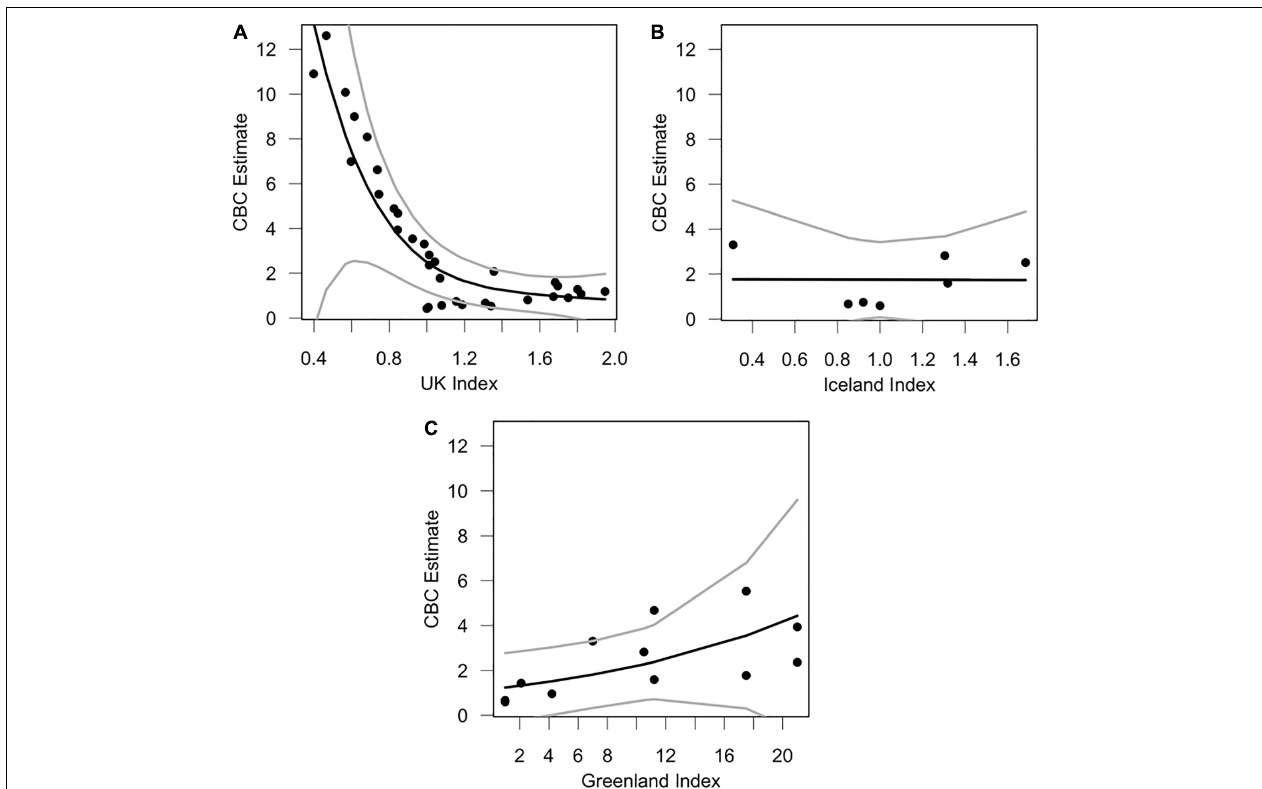
FIGURE 5 | Trends between annual breeding population size and numbers of vagrants using GAMs. The black line indicates the trend of the model, and the gray lines represent the lower and upper 95% confidence intervals. The graphs are allocated as follows: (A) CBC vagrants ∼ UK pairs, (B) CBC vagrants ∼ Iceland pairs, (C) CBC vagrants ∼ Greenland pairs. CBC vagrants are calculated as trend estimates from CBC surveys, which are an estimate of median abundance, using Bayesian hierarchical methods (Soykan et al., 2016; Meehan et al., 2020). Breeding pair indices were calculated as the percent change in total breeding pairs in that year relative to the base-year (first year of monitoring), which was set to 100%. Percentages were divided by 100 to create an